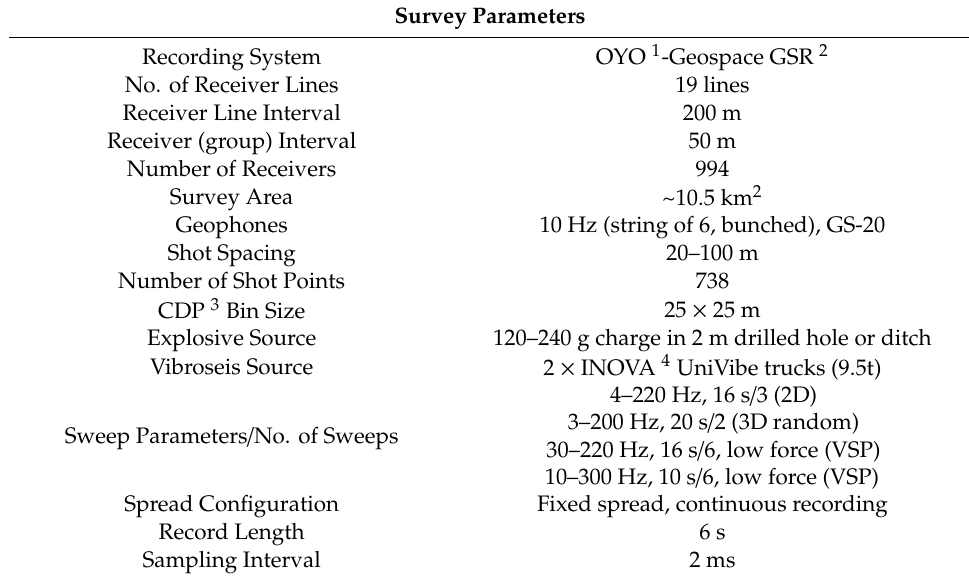
Table 1. Main acquisition parameters of COGITO-MIN 3D seismic